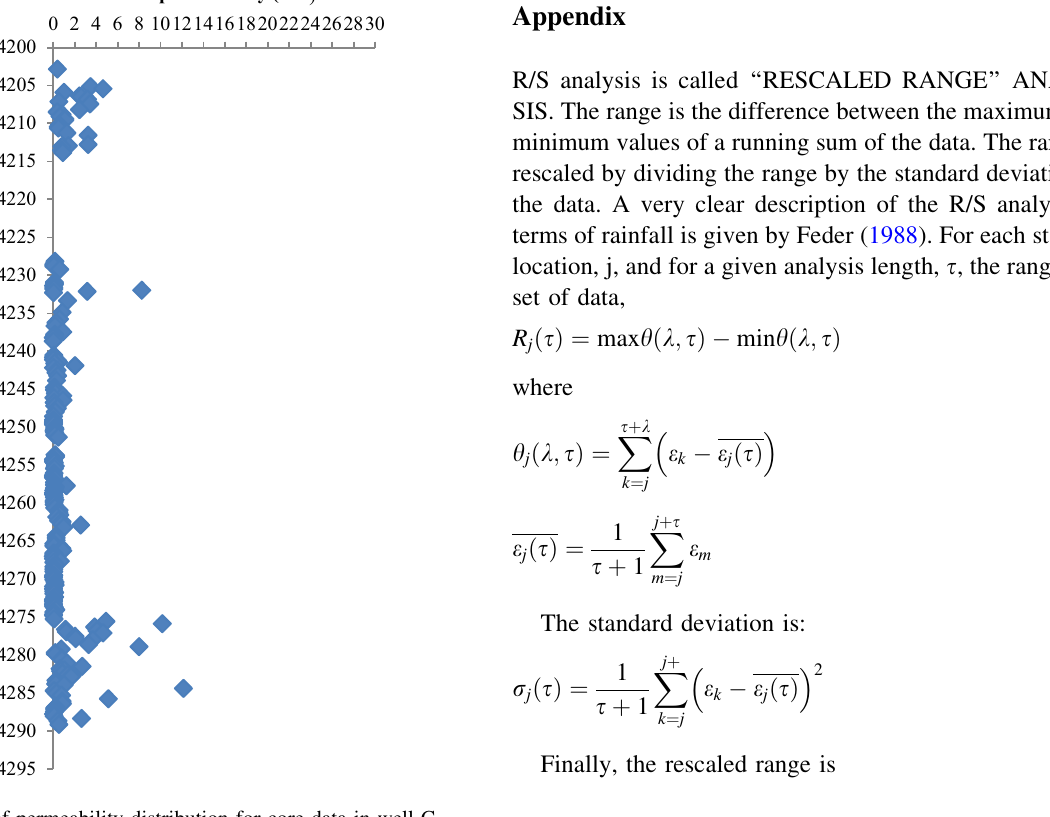
Fig. 12 Plot of permeability distribution for core data in well